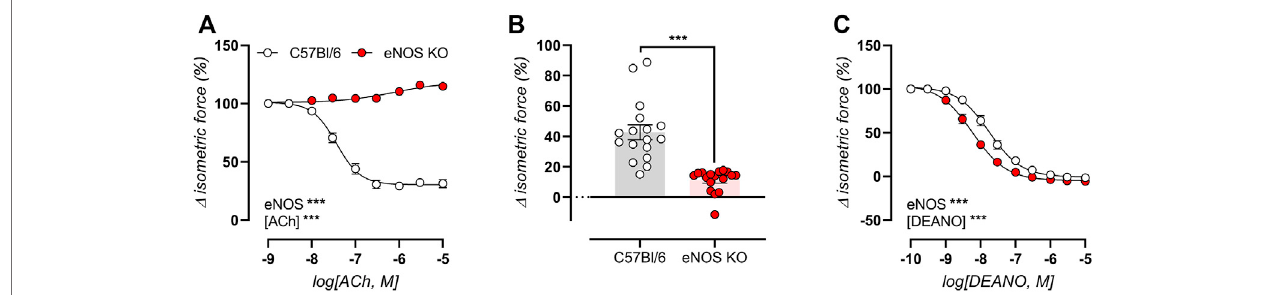
FIGURE 4 | Impaired endothelial NO production in eNOS knockout mice. Endothelial function was assessed in 6-month old eNOS knockout ( n = 17) and C57Bl/6 control ( n = 17) mice, by concentration-response stimulation with ACh in 2 µM PE-preconstricted aortic rings (A) , and by calculating of basal NO production as the relative difference in 2 µM PE-induced contraction in the absence and presence of NO blocker L -NAME (300 µM) (B) . The sensitivity of VSMC to exogenous NO was assessed using concentration-response stimulation with DEANO in 2 µM PE-preconstricted aortic ring in the presence of 300 μ M L -NAME to exclude possible endothelial-dependent NO effects (C) . Statistical analysis was preformed using two-way ANOVA (A,C) or student t -test (B) . Only the overall signi fi cance (bottom left) of ANOVA tests is listed. ns, p > 0.05; *, p < 0.05; **, p < 0.01; ***, p <